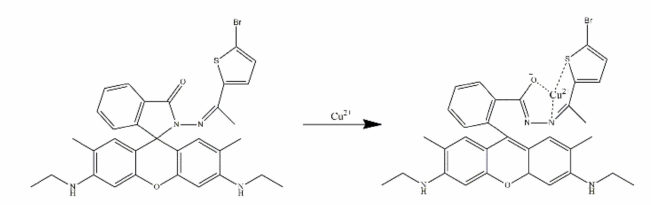
Figure 15. The proposed mechanism of 6GS2 (Table 1, No. 19) for sensing Cu 2+ [50]. Hosseinjani-Pirdehi H., et al., prepared a biocompatible fluorogenic chemosensor named RHA (Table 1, No. 20) [51]. Furan-2,5-dione and rhodamine combined with an iminohydrazine crosslinker were the receptor and fluorophore of RHA, respectively. The RHA served as a pH indicator in acidic media and a sensitive sensor with high selectivity to Cu 2+ RHA was used for bio-imaging applications in acidic and neutral pH. A novel sensor, named RhP, was synthesized by integrating the rhodamine phosphonate group (Table 1, No. 21) [52]. RhP demonstrated highly sensitive and selective recognition for Cu 2+ and the detection limit of RhP was 15 × 10 − 6 M. The sensing of Cu 2+ by RhP was achieved in less than 15 s (Figure 16).